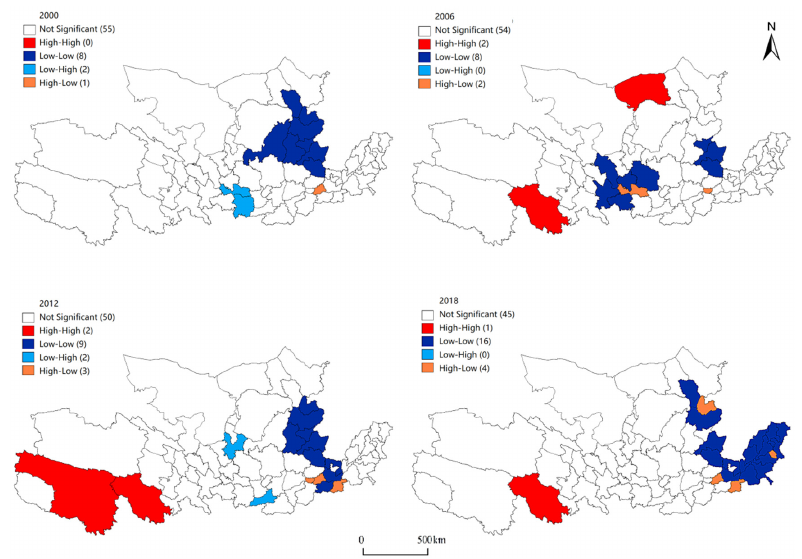
Figure 7. Local indicators of spatial association (LISA) aggregation map of GUECL in the Yellow River Basin.